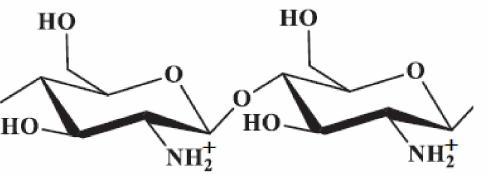
Figure 2. Schematic diagram of CS. This polycationic polymer has an amino group and two hydroxyl groups in each glycosidic unit. Positive charge the through polymer chain allows many electrostatic interactions with negatively charged